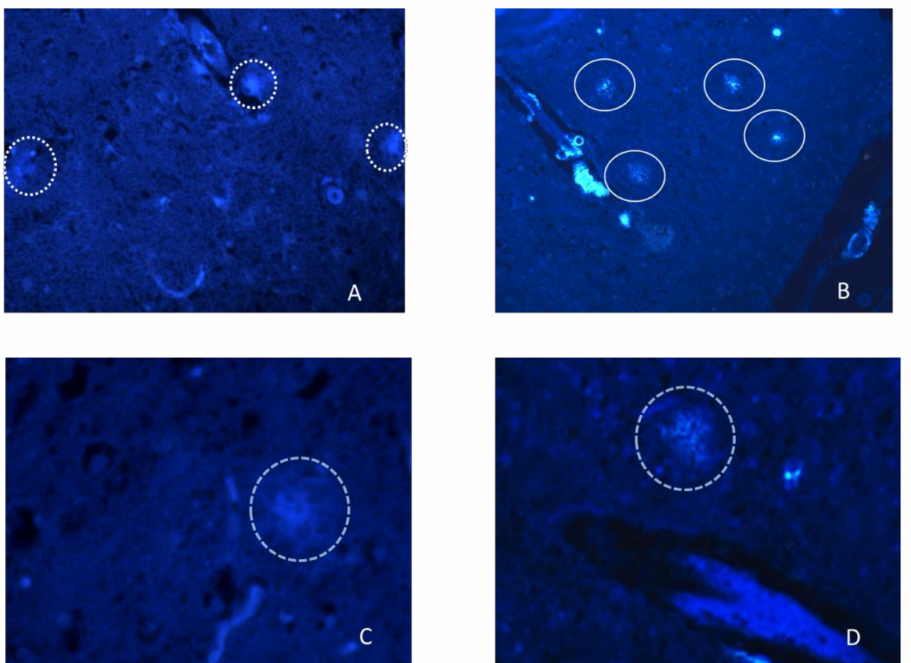
Figure 5. Confocal Fluorescence microscopy images (DAPI filter- λ ex = 360 nm, λ em = 420 nm), magnification × 20, ( A ) and ( B ); × 40 ( C ) and ( D ) of human post-mortem AD fixed brain sections treated with ( A , C ) compound 5a , ( B , D ) compound 5c (200 µ M). Dotted circles mark indicative “stained”